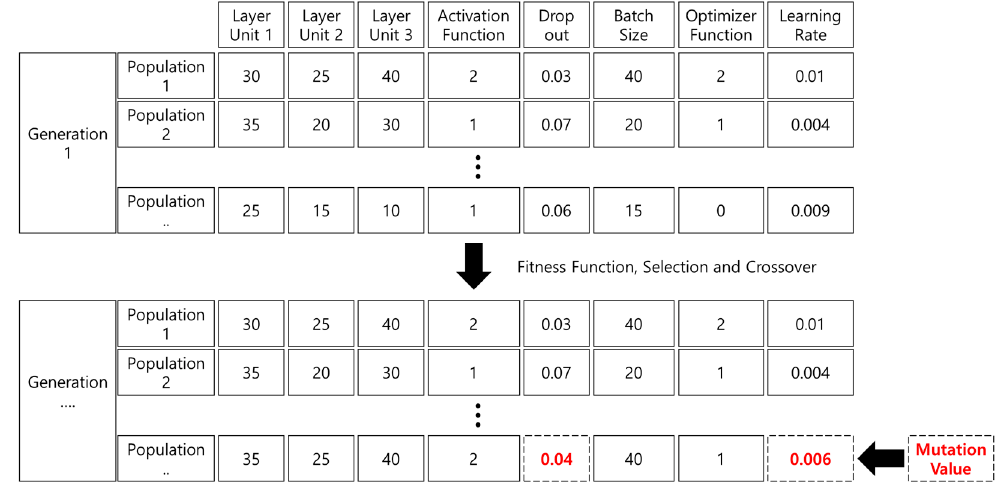
Figure 2. Flowchart of optimal model generation based on genetic algorithms. Table 1. RNN gene: hyper-parameters.